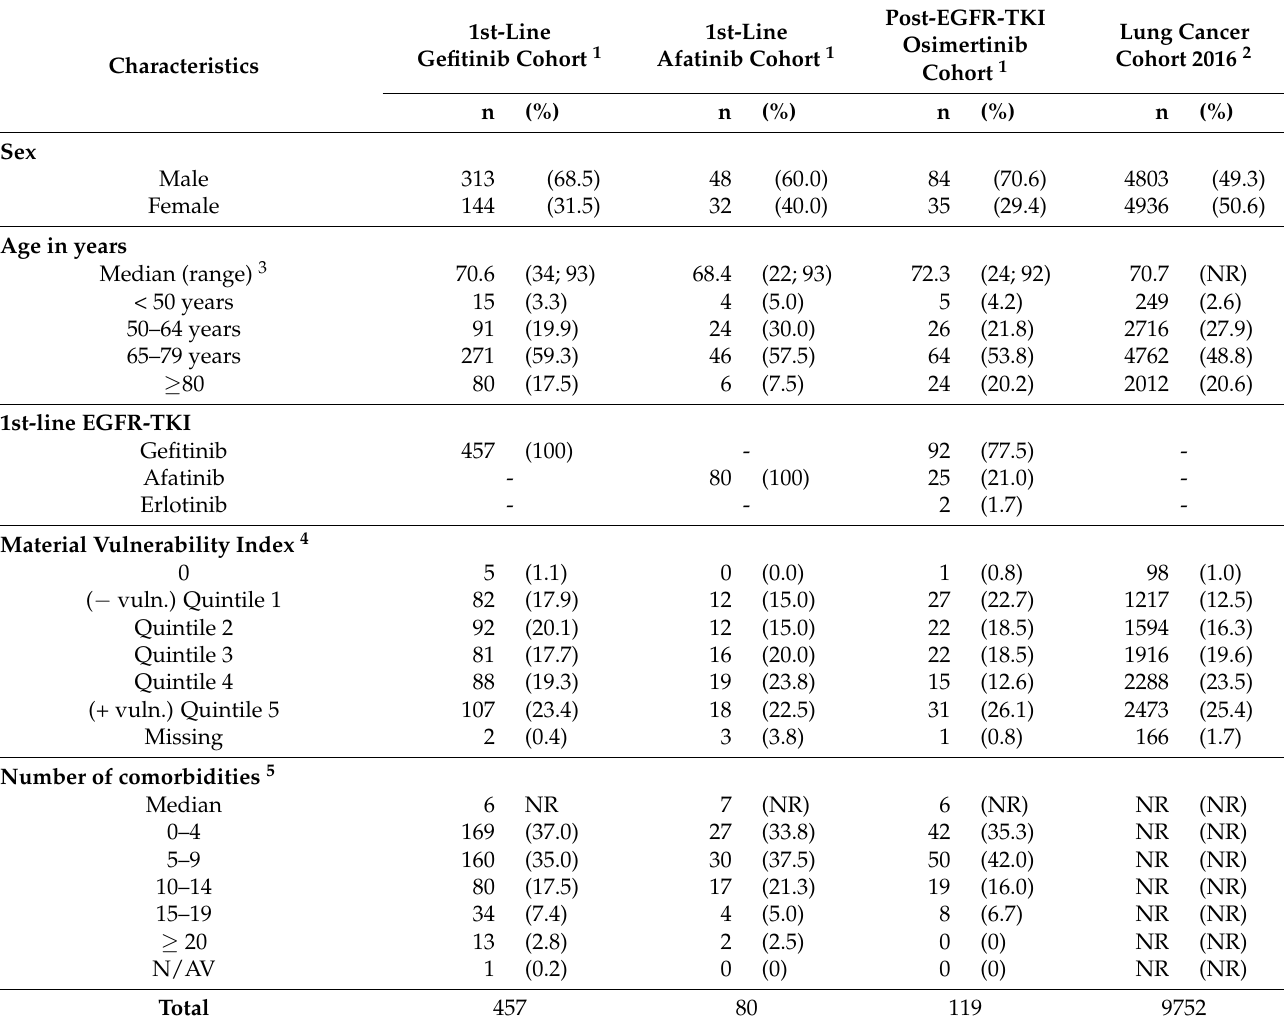
Table A8. Characteristics of Patients in Each EGR-TKI